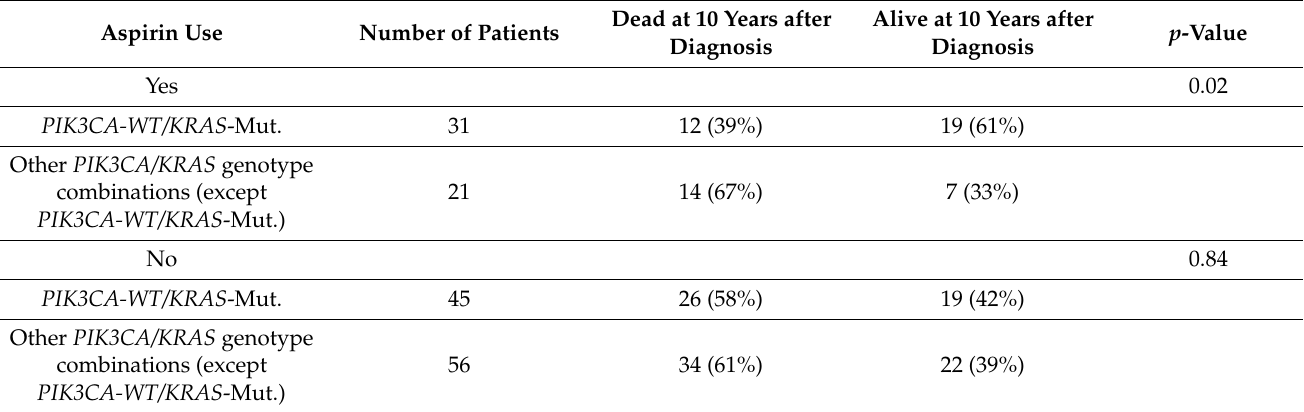
Table 2. The 10-year overall survival among patients with regular use or nonuse of aspirin after diagnosis of colorectal cancer according to PIK3CA and KRAS mutational